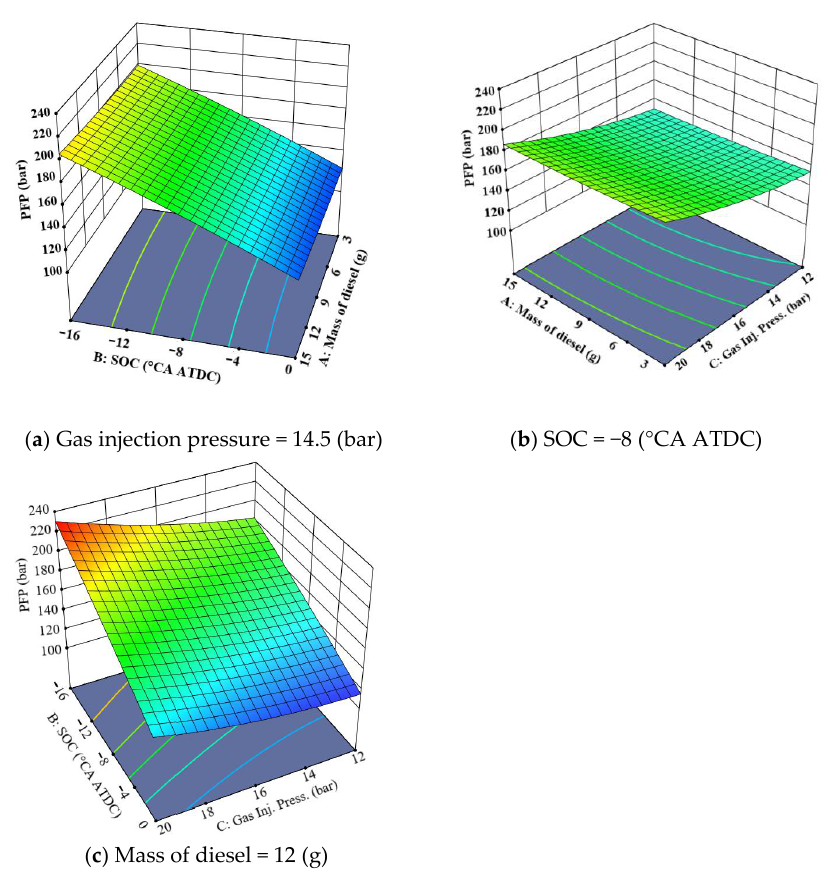
Figure 9. Response surface plot of the PFP.